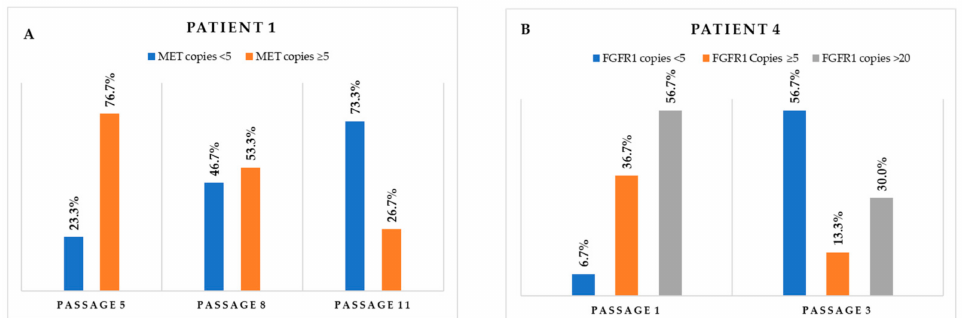
Figure 4. Monitoring of the variation through the different passages in cell populations carrying